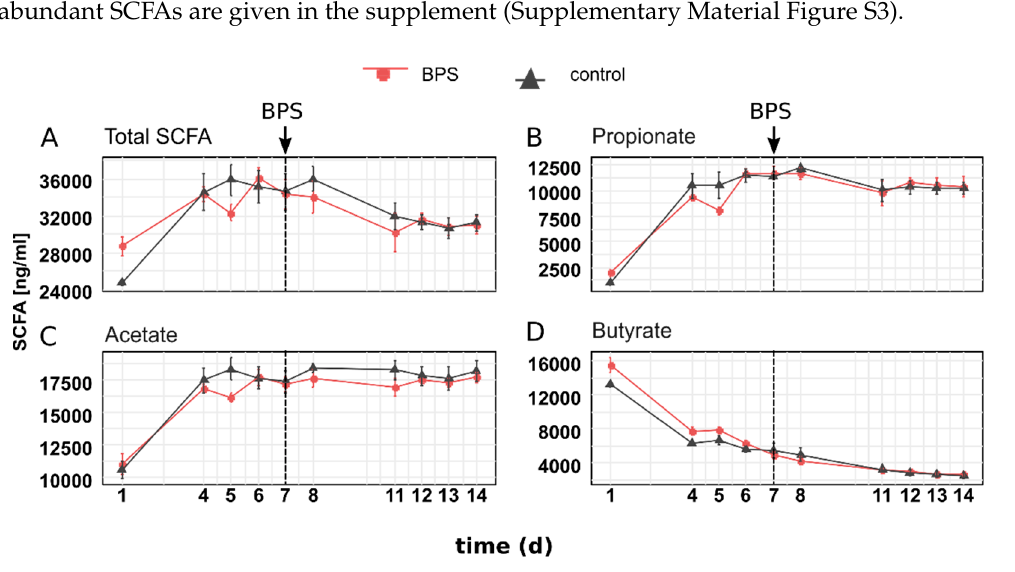
Figure 3. Total ( A ) and individual ( B – D ) S simplified human intestinal microbiota (SIHUMIx) concentrations of BPS and control bioreactors ( n = 3).